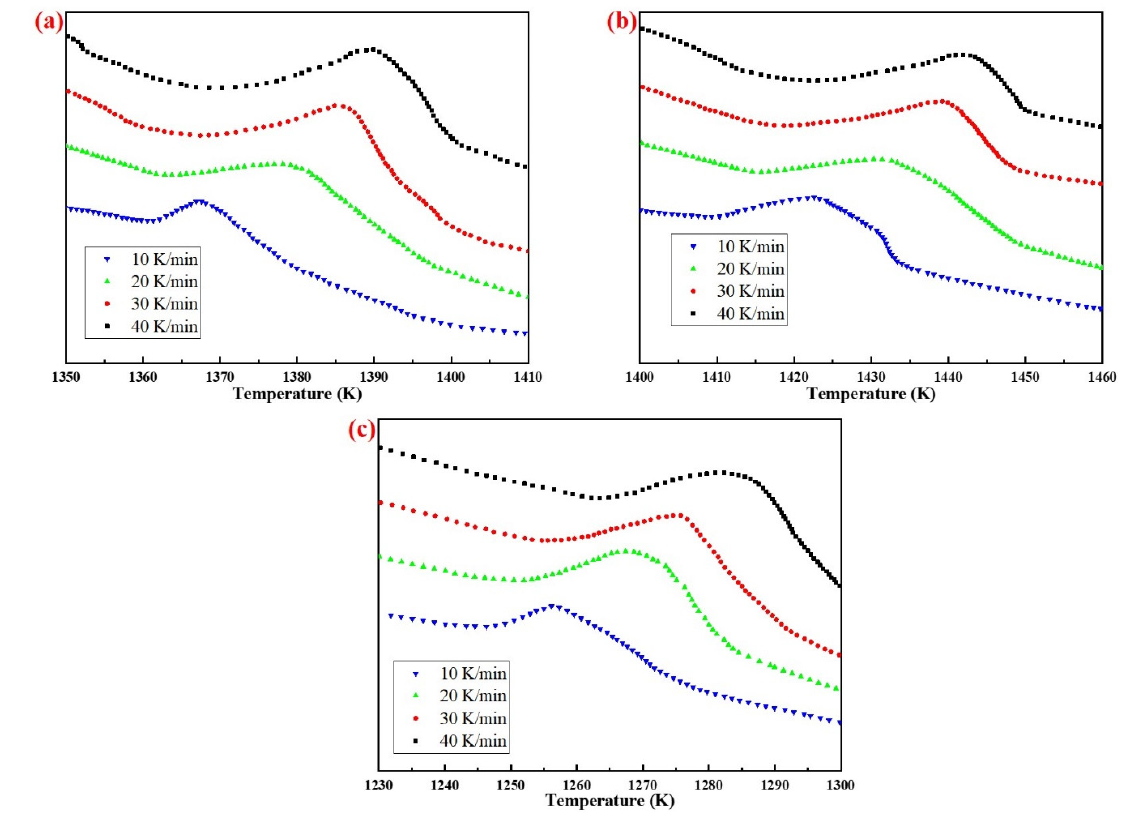
Figure 7. Differential thermal analysis of specimens from different silicon sources: ( a ) Fly ash; ( b ) Silica dust; ( c ) Gangue.